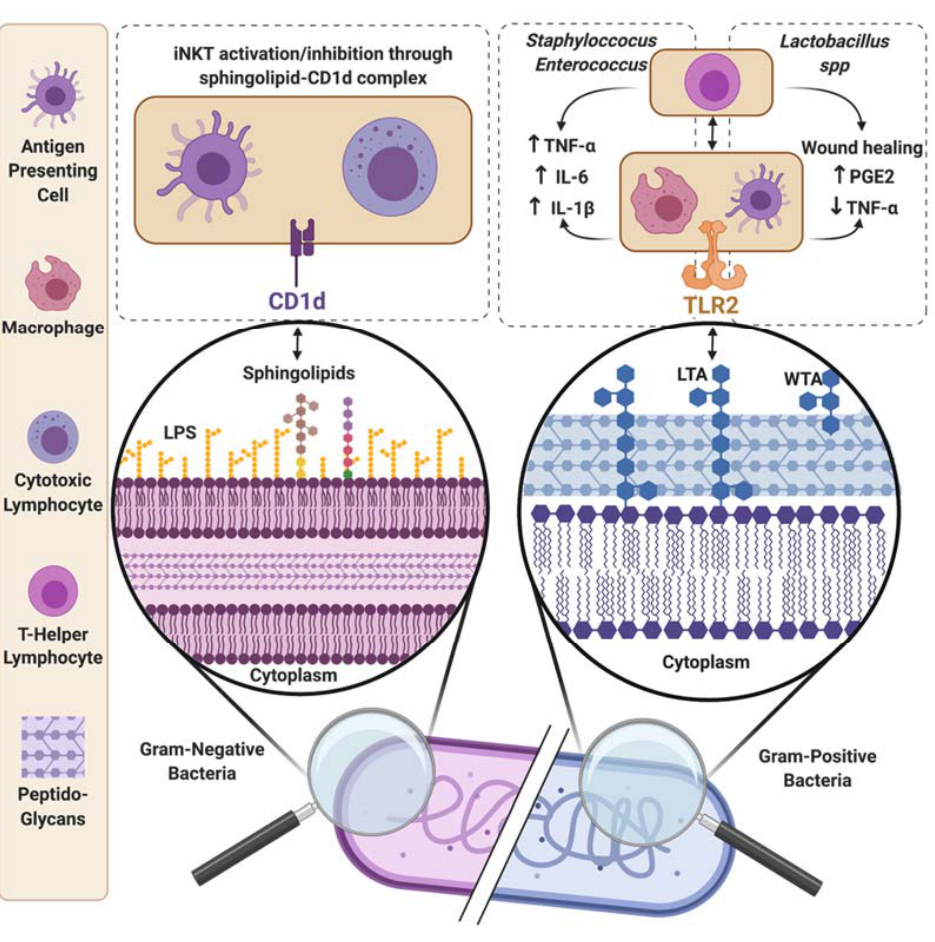
Figure 4. Summary of membrane-bound metabolites and their impact on immune cells. iNKT invariant Natural killer T, LTA, lipoteichoic acids; WTA, wall teichoic acids; PGE2, Prostaglandin E2.